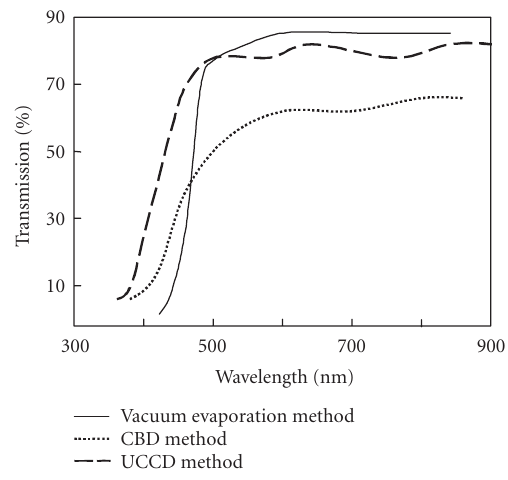
Figure 2: The transmission of a CdS film, using a vacuum evapo- ration method (solid line); using a chemical bath deposition (CBD) method (dotted line); and ultrasonical colloid chemistry deposition (UCCD) method (dashed